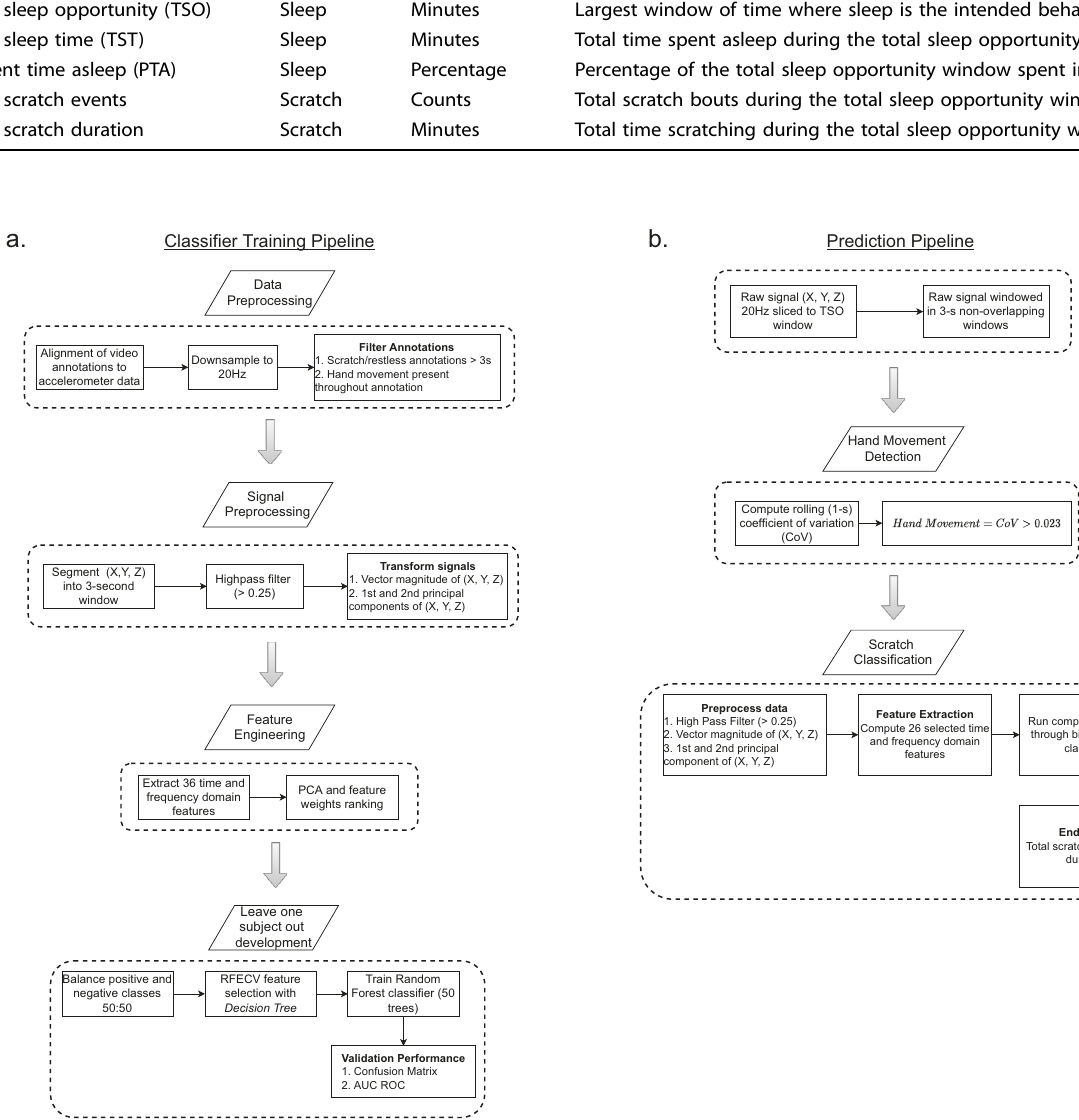
algorithm 35 to determine the presence of hand movement. The primary parameter of the hand movement algorithm (a threshold applied to rolling coef fi cient of variation) was tuned empirically based on our dataset. After testing several threshold values, we selected the 25th percentile of the distribution of coef fi cient of variation values (0.023) based on our dataset. Scratch classi fi cation was performed on a 3-s window only if hand movement was present for the entirety of the window. We trained a binary ML classi fi er to detect the presence of scratch. For training, we used all available 3-s windows across both in-clinic visits. To generate labels for training the classi fi er, instances of nighttime scratch